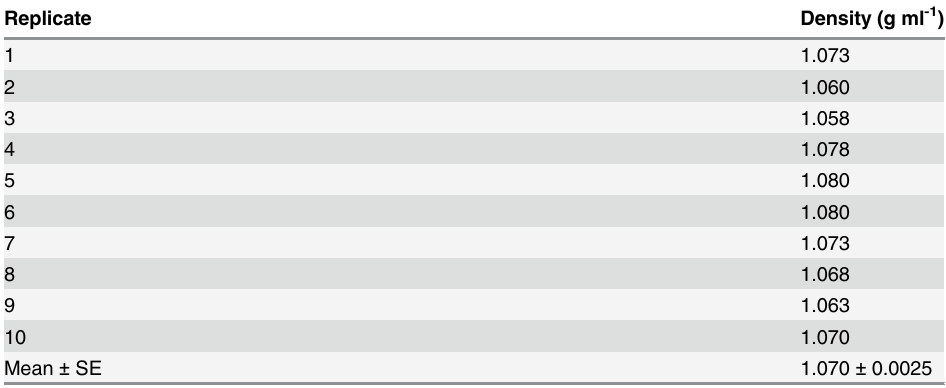
Table 6. Density of Bosmina longirostris carcasses measured with the density gradient method.